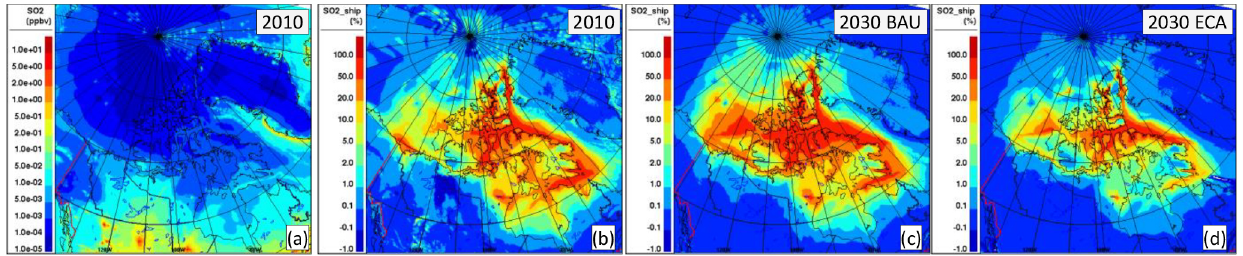
Figure 12. Modelled mean ambient SO 2 concentrations for July–August–September (shipping season) of 2010 base year (a) , and relative contribution from Canadian Arctic shipping emissions for the 2010 base year (a) , 2030 BAU (c) , and 2030 ECA (d) .